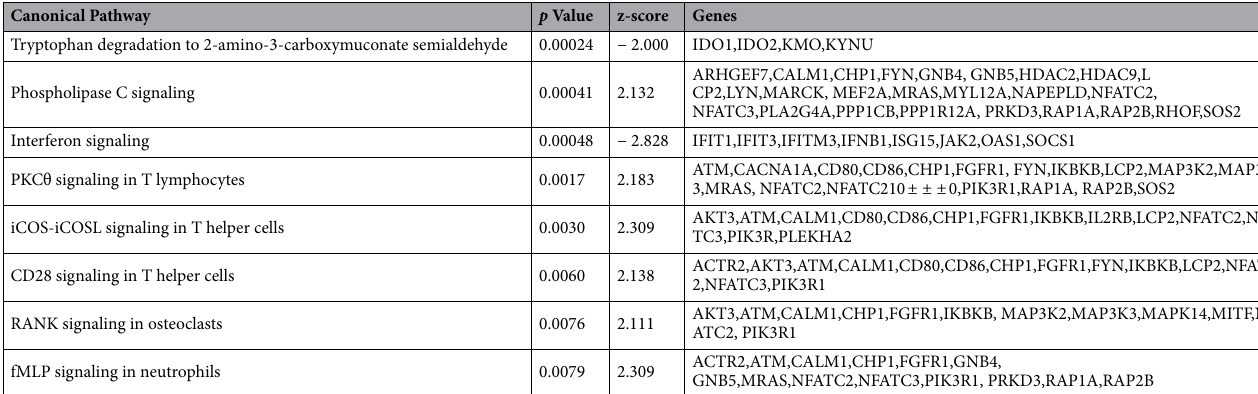
Table 2. Canonical pathways significantly impacted by Lp299v supplementation. * Lp299v = Lactobacillus plantarum 299v genes that were differentially expressed by at least 20% between pre- and post- Lp299v